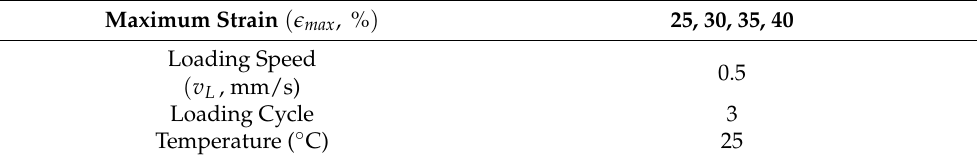
Figure 3. Dimension of the jig. Table 2. Experimental conditions.